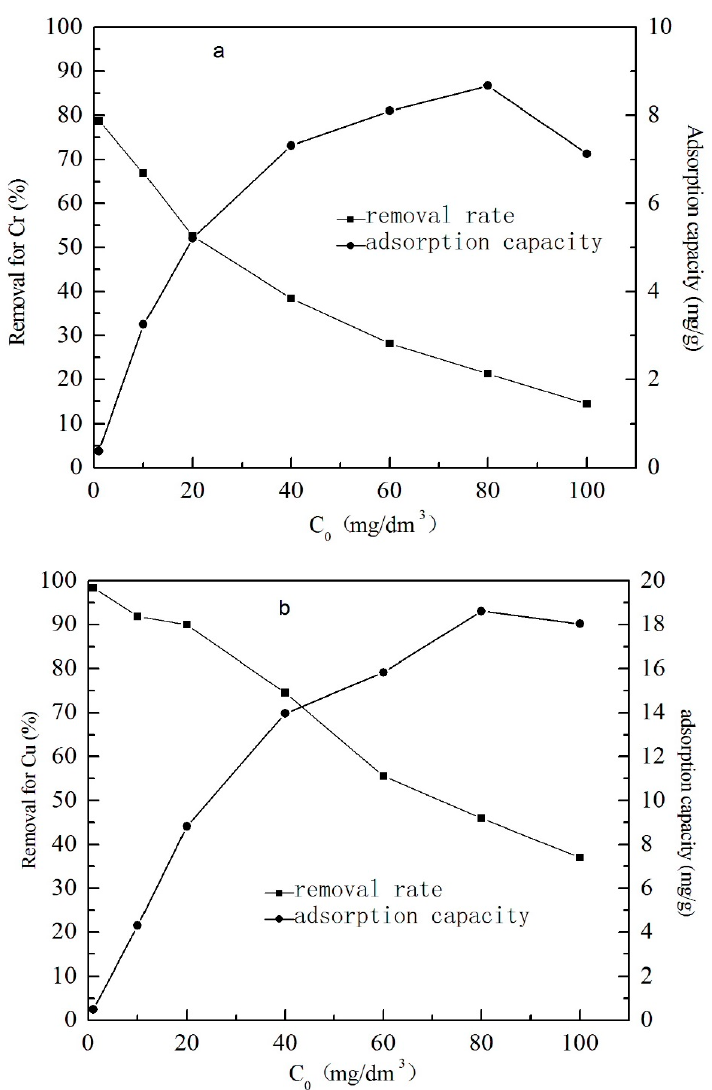
Figure 8. E ff ect of initial concentration on Cr ( a ) and Cu ( b ) removal in mixed Figure 8. Effect of initial concentration on Cr (a) and Cu (b) removal in mixed solution.